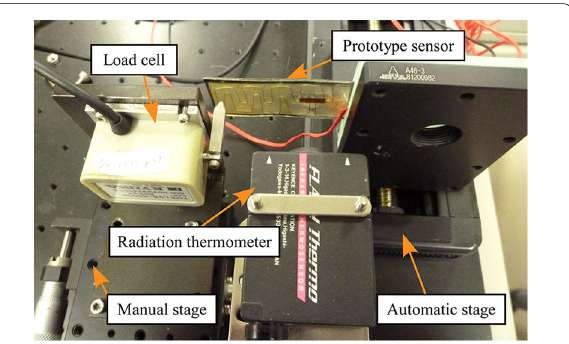
Fig. 3 Experimental apparatus used to evaluate the force sensor. A bending force was applied to the cantilever fixed prototype sensor by an indenter connected to a load cell. The prototype sensor was automatically displaced using an automatic